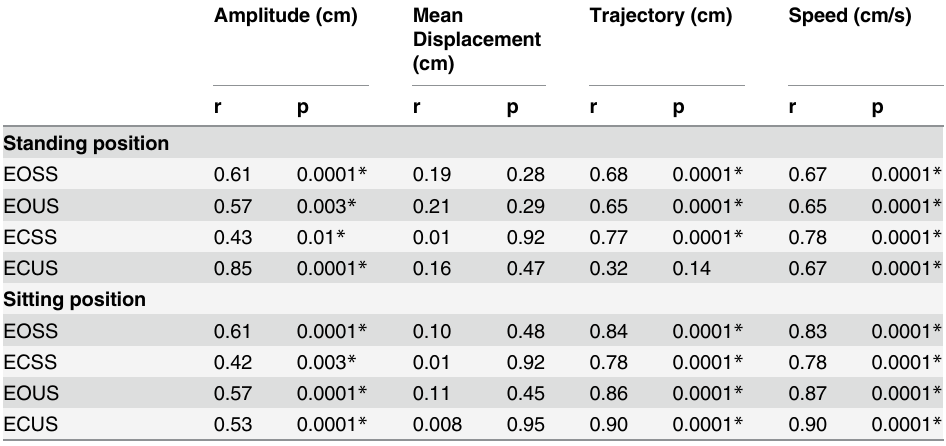
EOSS: eyes open stable surface ECSS: eyes closed stable